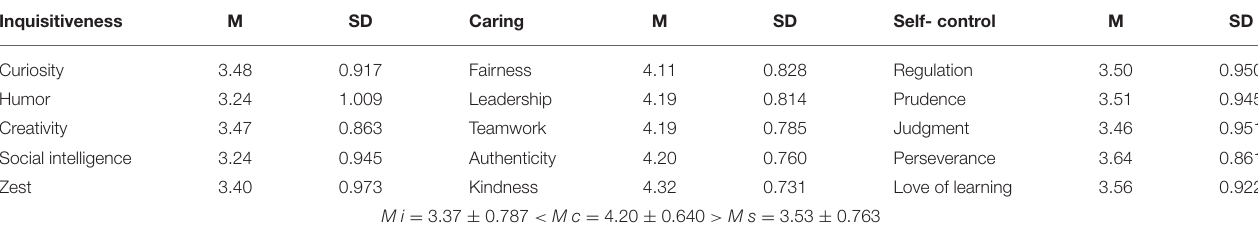
TABLE 3 | Means (M), SDs, and correlations of variables ( n = 1,221). Variables M